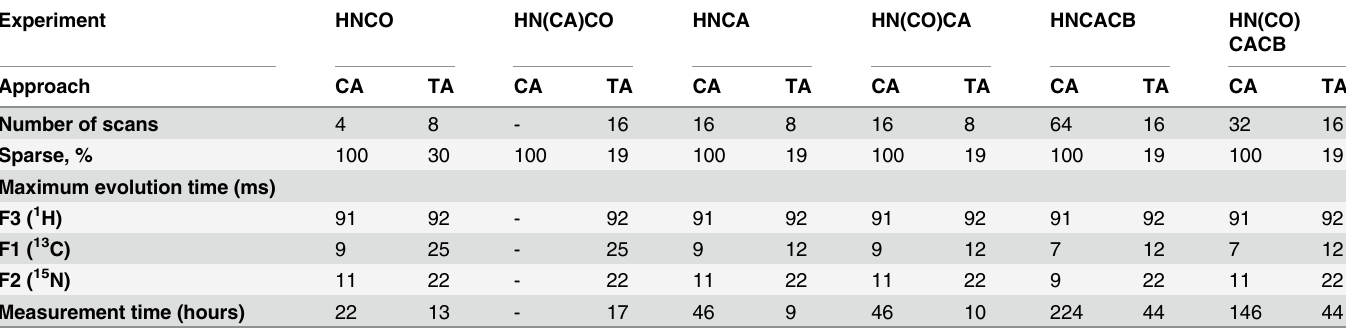
Table 1. Parameters used for acquisition of 3D NMR spectra using the conventional approach (CA) and Targeted Acquisition (TA). Experiment HNCO